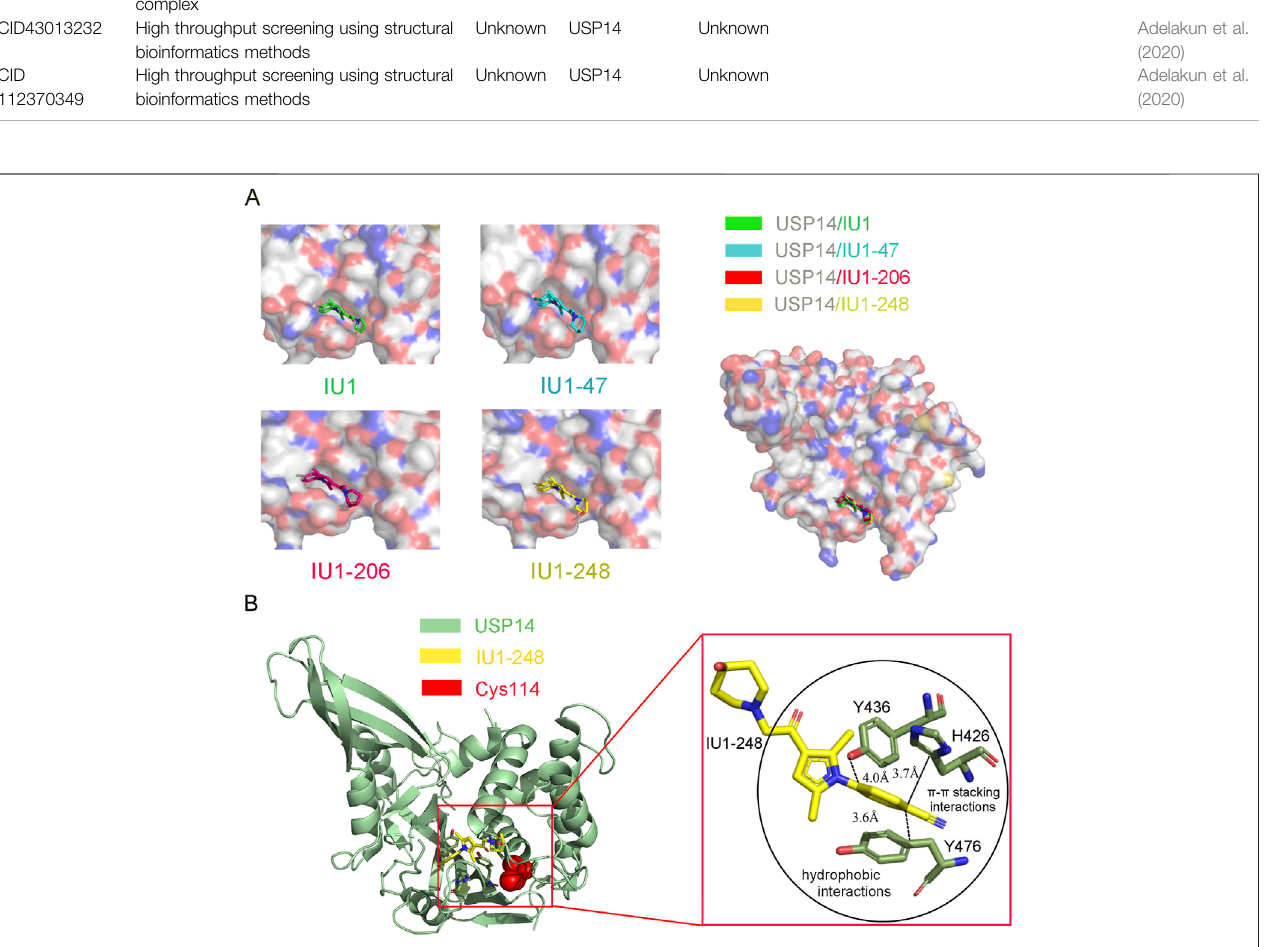
FIGURE 4 | Co-crystal structure of USP14 in complex with IU1-series inhibitors. (A) Left: The structure of USP14 with different inhibitors. IU1, IU47, IU1-206 and IU1-248 are shown in stick model and in green, cyan, magnet and yellow, respectively. USP14 is shown in surface model and the inhibitors are shown in stick model. Right: The overall structures of USP14 with four inhibitors. (B) The interactions between IU1-248 and USP14. USP14, IU1-248 and Cys114 are shown in cyan, yellow and red, respectively. USP14, IU1-248 and Cys114 are shown in cartoon, stick and sphere model, respectively.